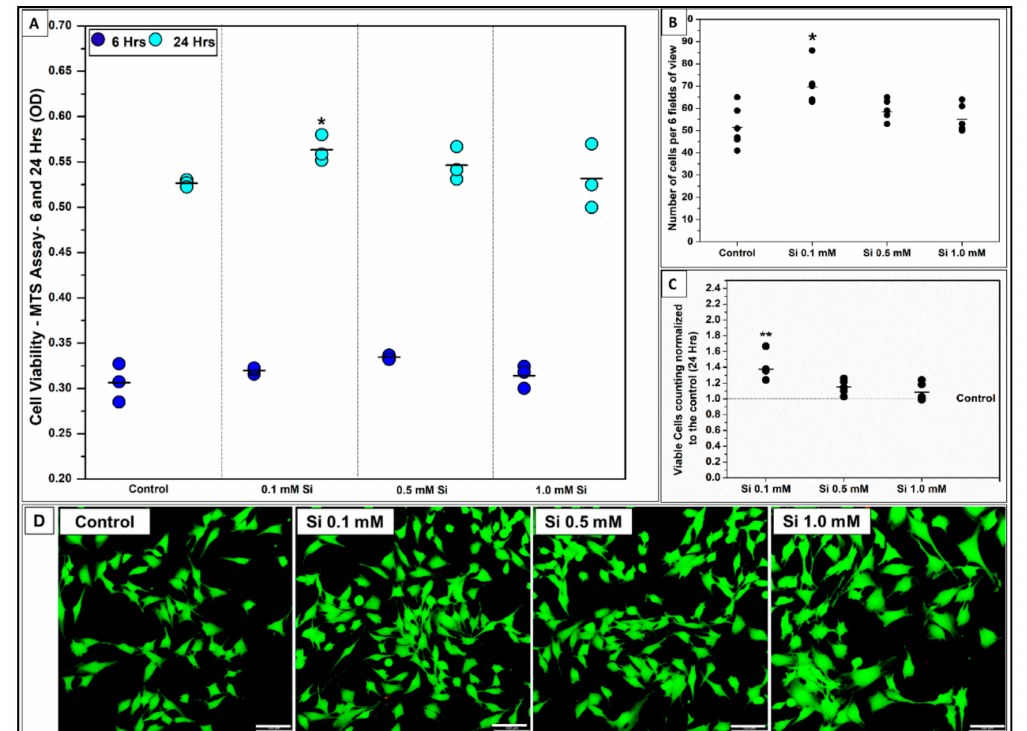
Figure 1. Effect of silicon ions on C2C12 myoblast cell viability. ( A ) Data distribution graph present the cell viability results using MTS-assay after 6 and 24 h of C2C12 cell culturing in growth media with three different concentration of Si 4+ (0.1, 0.5, and 1.0 mM). 0.1 mM of Si 4+ into the growth media significantly increases the cell viability after 24 h compared to the control (* p < 0.05, n = 3 per group). ( B ) Data distribution graph presents the number of cells per 6 fields of view confirming that 0.1 mM of Si 4+ significantly increase the number of cells after 24 h. ( C ) Bar graph shows the number of viable cells normalized to the control after 24 h, (** p < 0.01). ( D ) Fluorescent pictures (20 × view) of C2C12 cells stained with live/dead assay kit shows enhancement on cell viability after being exposed to ionic silicon. (—) in the graphs represents the mean and the scale bar in the fluorescent pictures is 100 µ